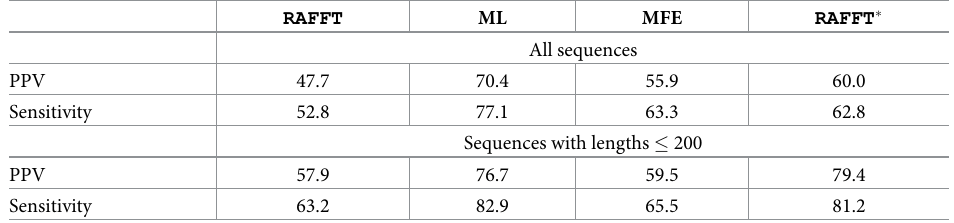
Table 1. Average performance displayed in terms of PPV and sensitivity. The metrics were first averaged at fixed sequence length, limiting the over-representation of shorter sequences. The first two rows show the average perfor- mance for all the sequences for each method. The bottom two rows correspond to the performances for the sequences of length � 200 nucleotides. For the ML and MFE only one prediction per sequence and for RAFFT 50 predictions per sequence were used. Here RAFFT (respectively RAFFT � ) refers to the case when the lowest free energy (resp. highest PPV) from the ensemble of 50 predictions is selected.